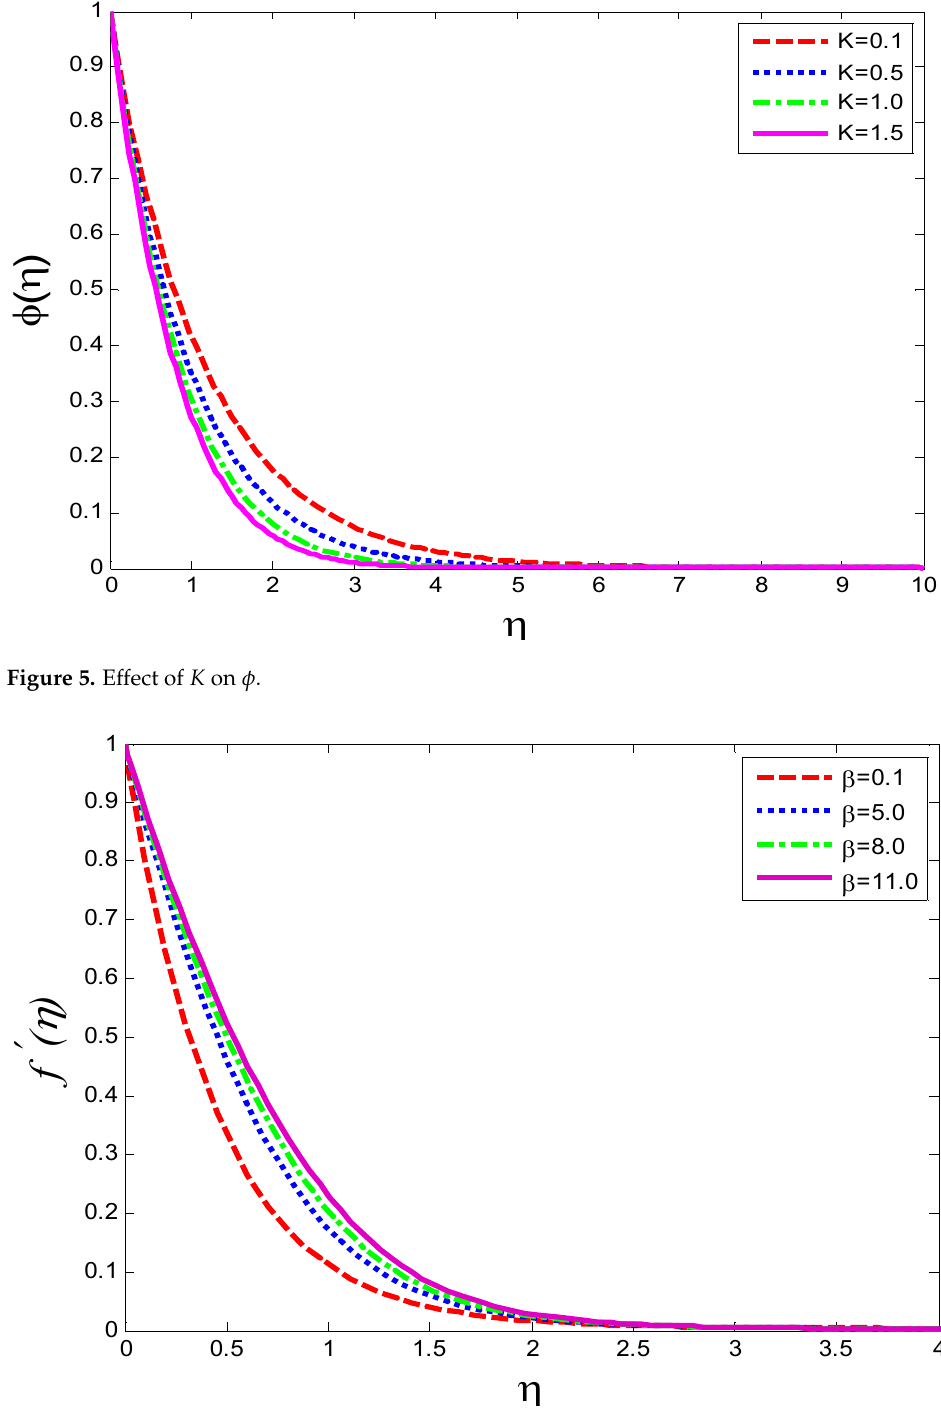
Figure 6. Effect of β on f (cid:48) ( η )